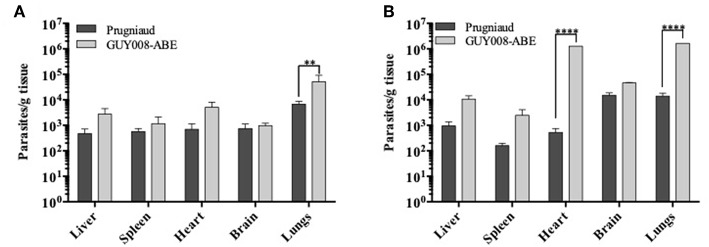
Parasites load of rat organs following Toxoplasma gondii infection. Rats were intraperitoneally infected with 107 tachyzoites of type II Prugniaud (n = 8) or GUY008-ABE (n = 8) strains. Animals were sacrificed at days 4 (A) or 14 post-infection (B). Parasite loads were expressed as parasites per tissue gram and mean ± SEM represented. Values were submitted to 2way ANOVA analysis followed by a Tukey's multiple comparisons test (**p < 0.005, ****p < 0.00005).